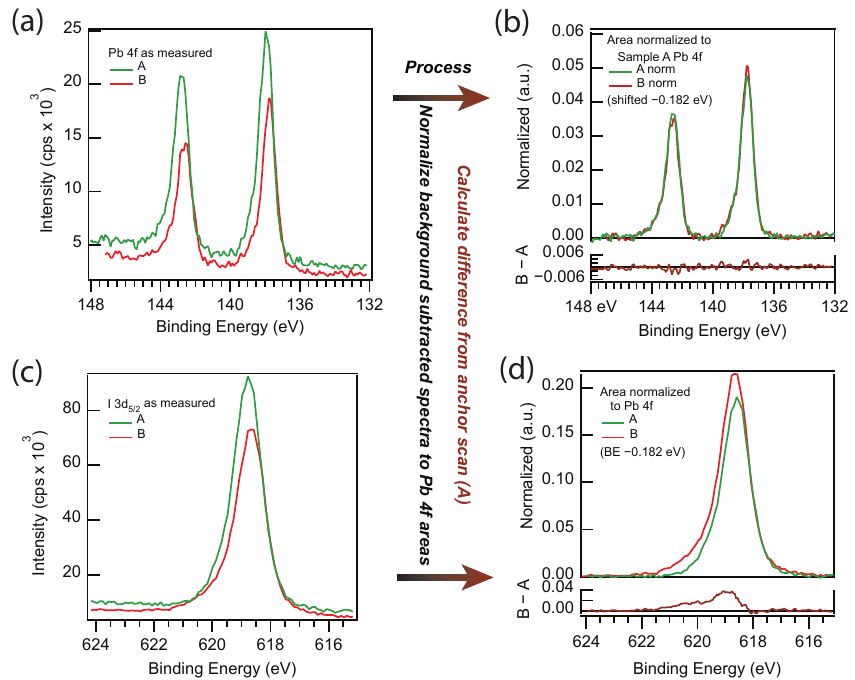
Figure 3. Characteristic measured and processed spectra for Pb 4f and I 3d 5/2 difference spectra treated as described in the Methods section. Process routine is illustrated. ( a ) As-measured Pb 4f core level XPS spectra for samples A and B. ( b ) Pb 4f spectra divided by total area for each curve. BE is shifted for sample B to align main peak. Difference spectra shown for sample B minus sample A. ( c ) As-measured I 3d 5/2 core level XPS spectra for samples A and B. ( d ) I 3d 5/2 spectra divided by total Pb 4f area. BE is shifted for sample B by same amount as in panel ( b ). Difference spectra shown for sample B minus sample A. Data shown is reprinted (adapted) from supporting information Figure S4 with permission from [35] Copyright 2021 American Chemical